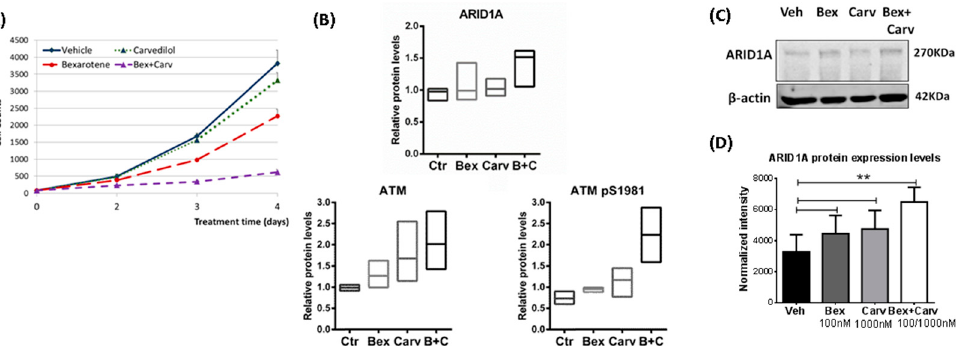
Figure 1. The effect of the combined treatment by Bex and Carv in HME-hTert on cell proliferation and the chromatin surveillance factors ATM and ARID1A. Bexarotene and carvedilol combination treatment showed anti-proliferative effects in normal HME-hTert cells associated with an induction in ARID1A protein levels. ( A ) Dose-response profile of the effect of Bex+Carv combination treatment on HME-hTert cells proliferation treated with the individual or combination treatment for 4 days. ( B ) Reverse phase proteomic array results show the protein levels of ARID1A and ATM as well as the phosphorylated ATM at S1981 upon Bex and/or Carv combination treatment in HME-hTert cells. ( C ) Western blot analysis of ARID1A protein expression levels in extracts from HME-hTert cells treated with the combination of 100 nmole/L Bex and/or 1000 nmole/L Carv vs vehicle for 48 h. β -actin protein levels were used for normalization. ( D ) Quantification of ARID1A integrated intensity derived from HME-hTert cells treated with the combination or the individual treatments and immunostained with ARID1A. About 200 cells per replicate were analyzed using ImageJ software based on integrated cellular pixel intensities of the immunostaining for ARID1A, normalized to cell numbers based on DAPI nuclear staining. The results are expressed as mean ± SD ** p < 0.01 by One-way ANOVA, Tukey post-hoc test.